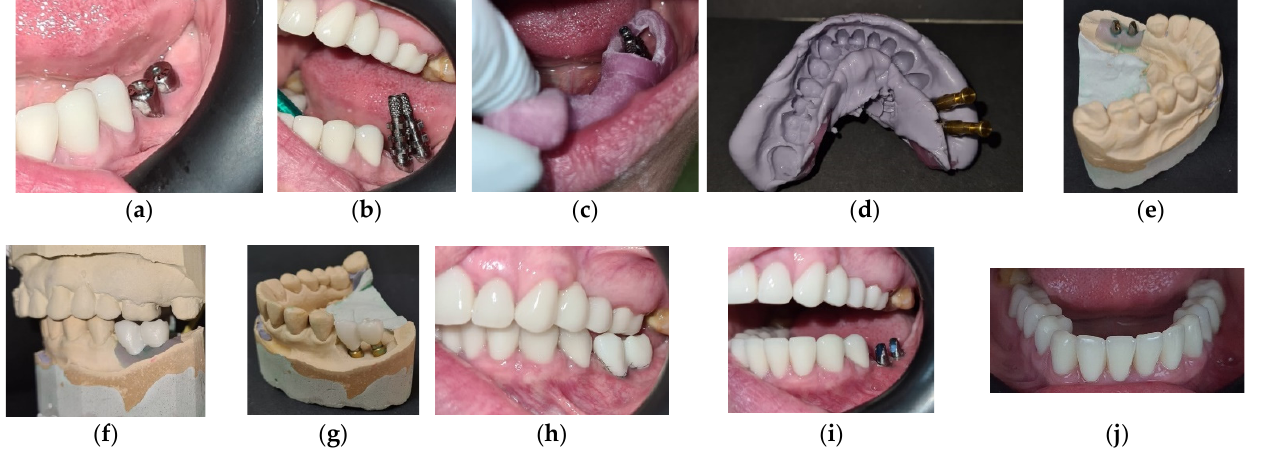
Figure 10. Panoramic X-ray with the osseointegrated implants on the lower arch and the good marginal adaptation of all the restorations.